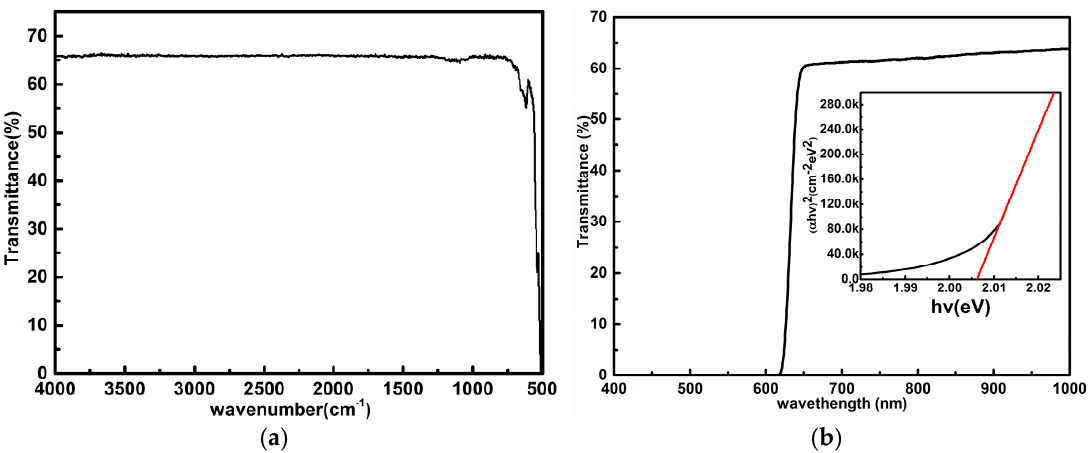
Figure 3. ( a ) Typical IR transmittance spectrum of a GaSe sample; and ( b ) the ultraviolet–visible–near IR spectrum of the GaSe sample.